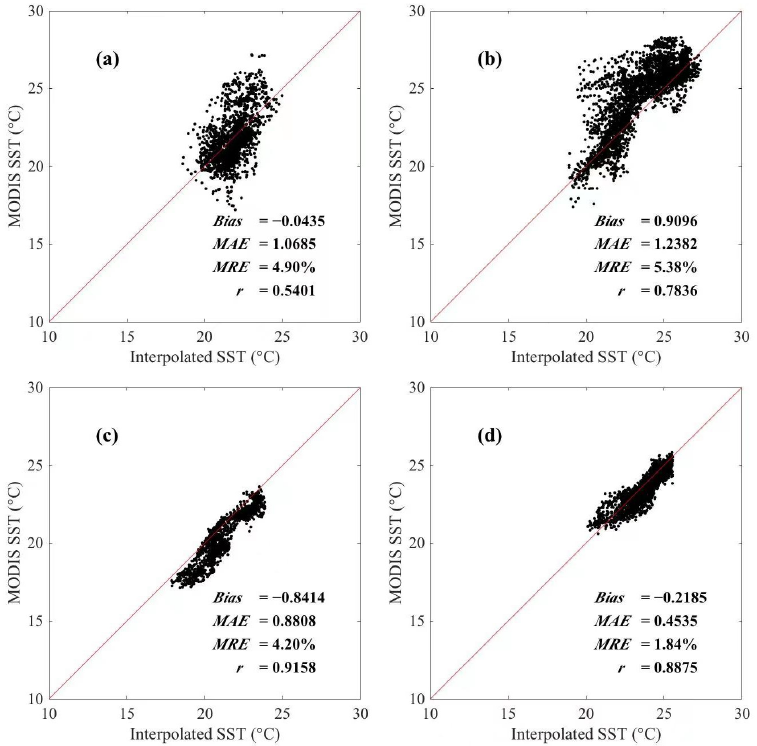
Figure 14. Scattered plots of the match-up pairs between the interpolated SST and satellite-derived SST. ( a ) Summer 2010; ( b ) Summer 2011; ( c ) Autumn 2010; and ( d ) Autumn 2011.